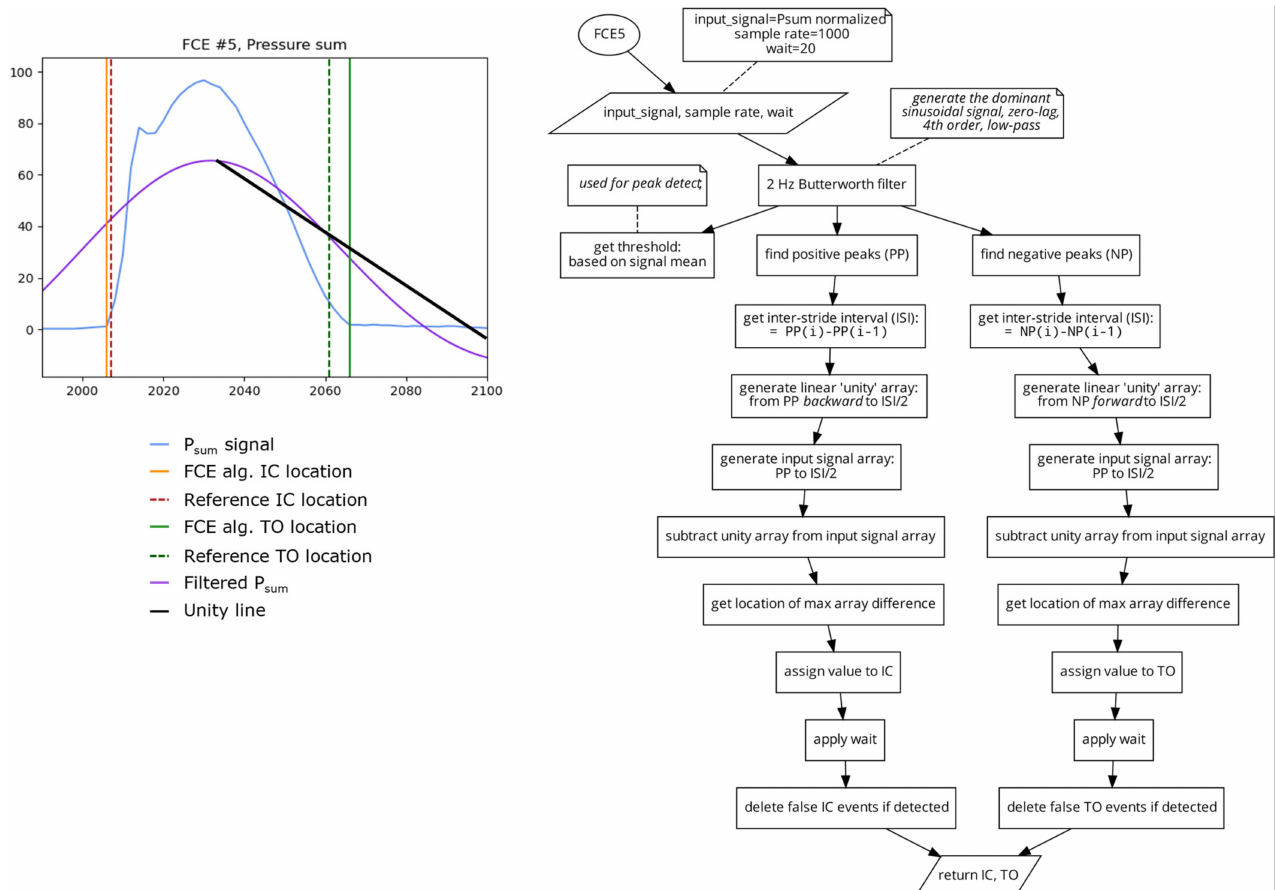
Figure 8. Plot ( left ) displaying a single stride and the location of the reference FCEs (dashed vertical) and the FCEs (solid vertical), as determined by the FCE5 algorithm ( right